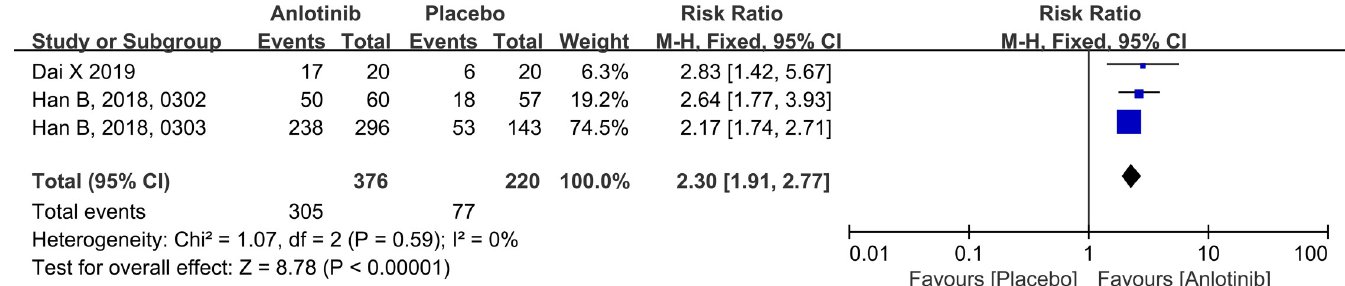
Fig 6. Forest plot comparing the DCR between the anlotinib and placebo groups with advanced NSCLC. The blue squares represent the RR of a study, and the black line their confidence intervals. The black diamond represent the pooled RR and its confidence interval.